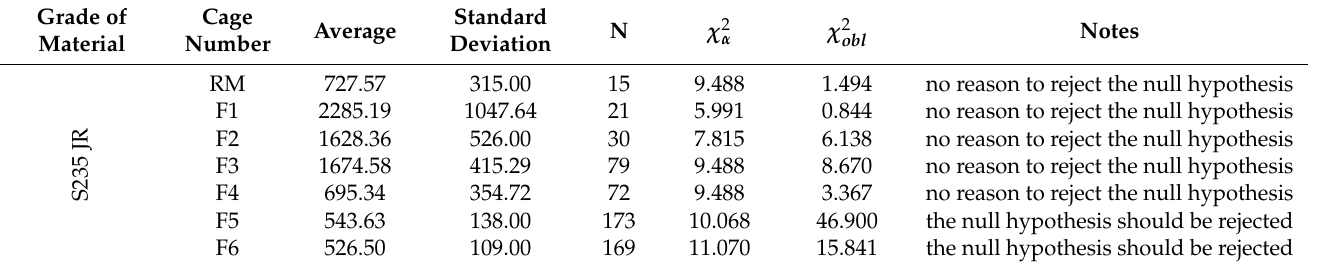
Table 2. Statistical distribution of the life of